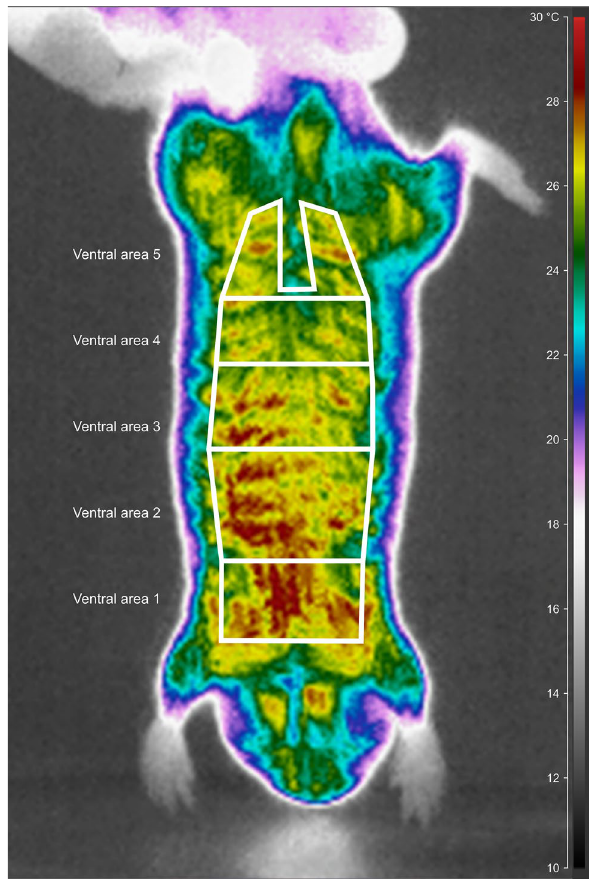
Figure 1. A schematic illustration of the layout of the five ventral areas for which surface temperatures were measured. The background is an infrared thermogram of the Ansell’s mole-rat, F. anselli taken after acclimation at 10 °C. The figure was prepared using the program Inkscape 0.92 (https ://inksc